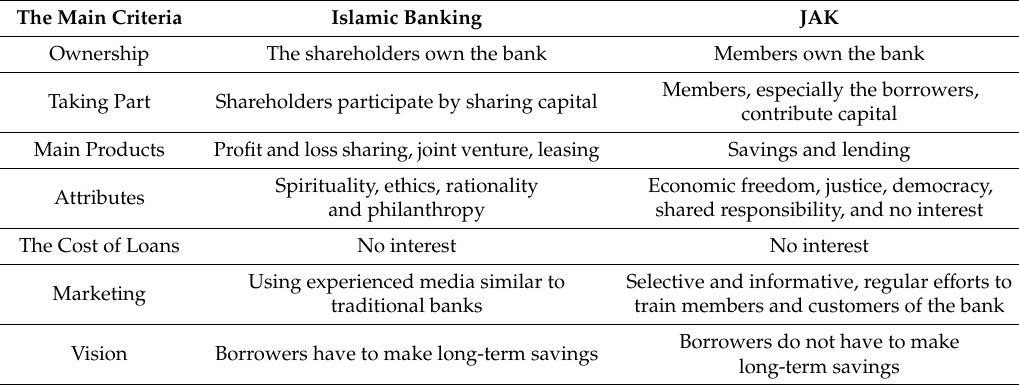
Table 2. Main di ff erences between Islamic Banking and